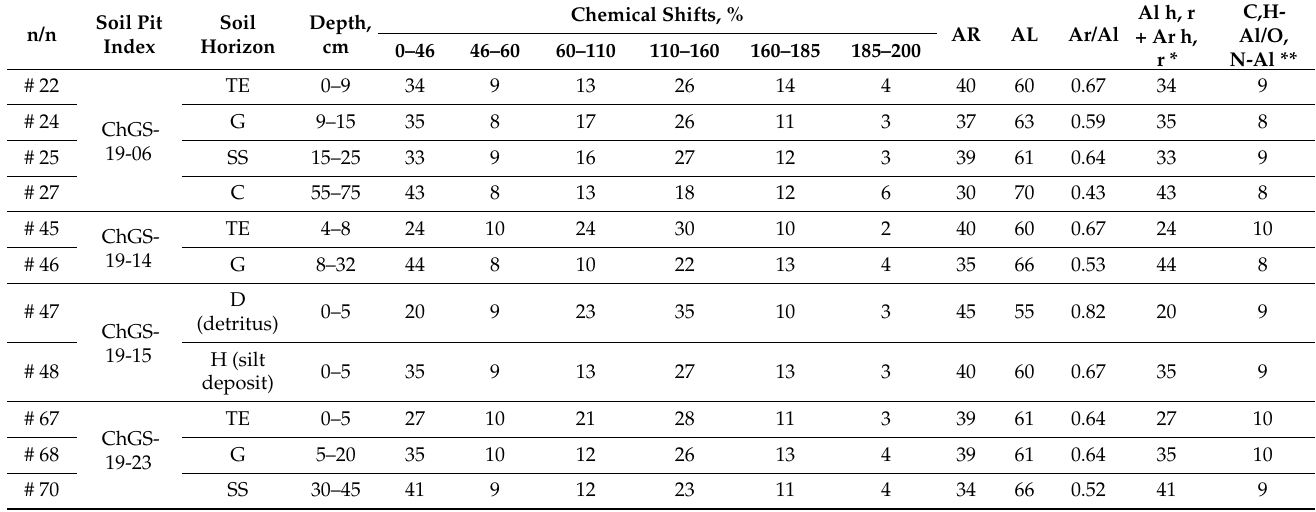
Table 3. Percentage ratio of the main structural fragments of HAs.